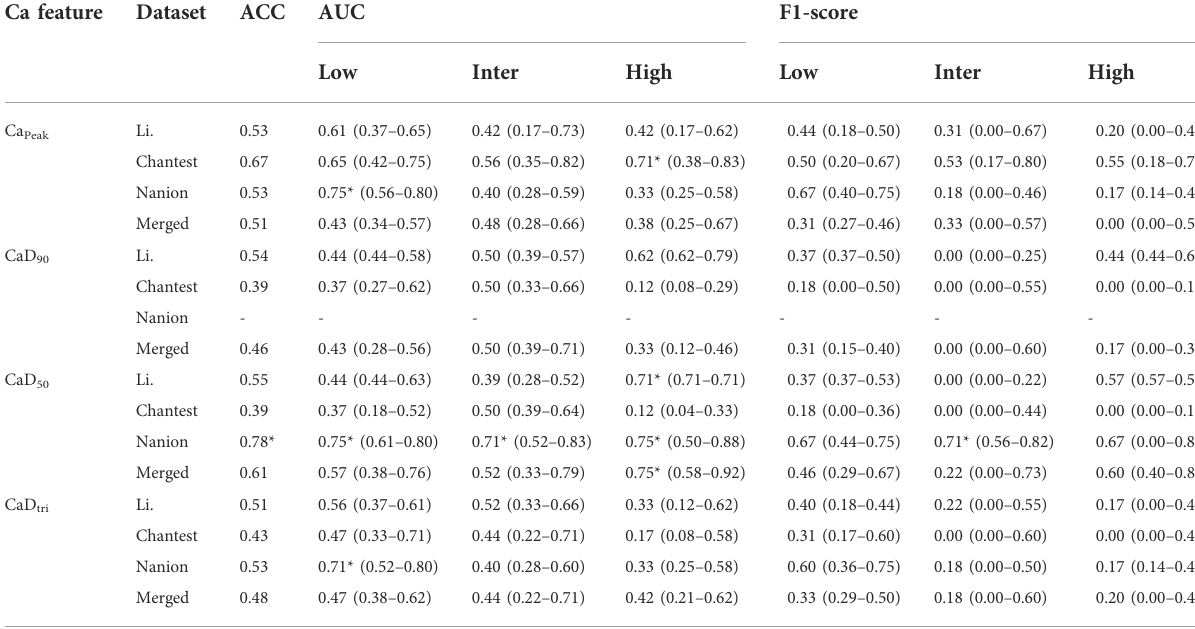
TABLE 4 Summary of classi fi cation performance using calcium (Ca) features; classi fi cation performances according to the AP features shows the median, minimal and maximal values after evaluating the model through the 10,000-test algorithm; AUC, the area under the receiver operating curves; Merged, the combined set containing all three datasets; ACC, accuracy; One asterisk (*) denotes the intermediate performance over 0.7 of median values, and two asterisks (**) denote the excellent performance over 0.8 of median values.